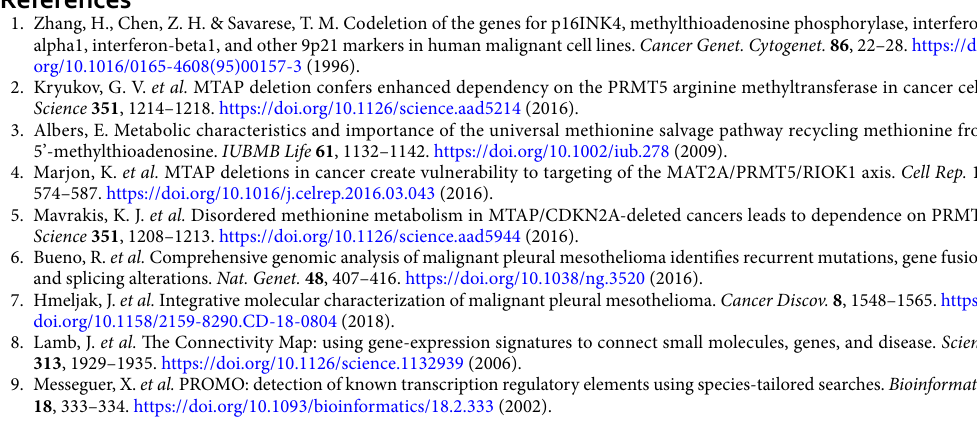
Figure 4. Quinacrine transcriptionally regulates PRMT5 via c-JUN ( A ) PRMT5 mRNA expression was evaluated by qRT-PCR on RNA extracted from cells transfected with siNT, siCEBP1, sic-JUN, siNF-YA 20 nM, for 72 h. Data were normalized to siNT (siCEBP1 p = n.s.; sic-JUN p = 0.0001; siNF-YA p = n.s). CEBP1, c-JUN and NF-YA mRNA expression was evaluated by qRT-PCR on RNA extracted from cells transfected with siNT, siCEBP1, sic-JUN, siNF-YA 20 nM, for 72 h. Data were normalized to siNT (NCI-H2591: siCEBP1 p = 0.0001; sic-JUN p = 0.0006; siNF-YA p = 0.0033. NCI-H2052: siCEBP1 p = 0.0001; sic-JUN p = 0.0009; siNF-YA p = 0.0001). ( B ) Cell proliferation was measured by clonogenic assay 5–7 days after treatment. Data were normalized to siNT (NCI-H2591: siCEBP1 p = n.s.; sic-JUN p = 0.0073; siNF-YA p = n.s. NCI-H2052: siCEBP1 p = n.s.; sic-JUN p = 0.0001; siNF-YA p = 0.0001). The levels of PRMT5 and c-JUN expression and H4 arginine 3 symmetrical di-methylation (H4R3me2S) were measured by western blot. These gels have been cropped and full length gels are presented in Supplementary Fig. 3J–K. (C ) C-JUN mRNA expression was evaluated by qRT-PCR on RNA extracted from cells treated for 72 h with Quinacrine 1 µM. Data were normalized to untreated controls (NCI-H2591 p = 0.0001. NCI-H2052 p = 0.0276). ( D ) PRMT5 and cJUN mRNA expression was evaluated by qRT-PCR on RNA extracted from MPP89 cells transfected with siNT, sic-JUN 20 nM, for 72 h. Data were normalized to siNT (PRMT5 p = n.s. c-JUN p = 0.0205). ( E ) Cell proliferation was measured by clonogenic assay 5–7 days after treatment. Data were normalized to siNT (sic-JUN p = n.s). The levels of PRMT5 and